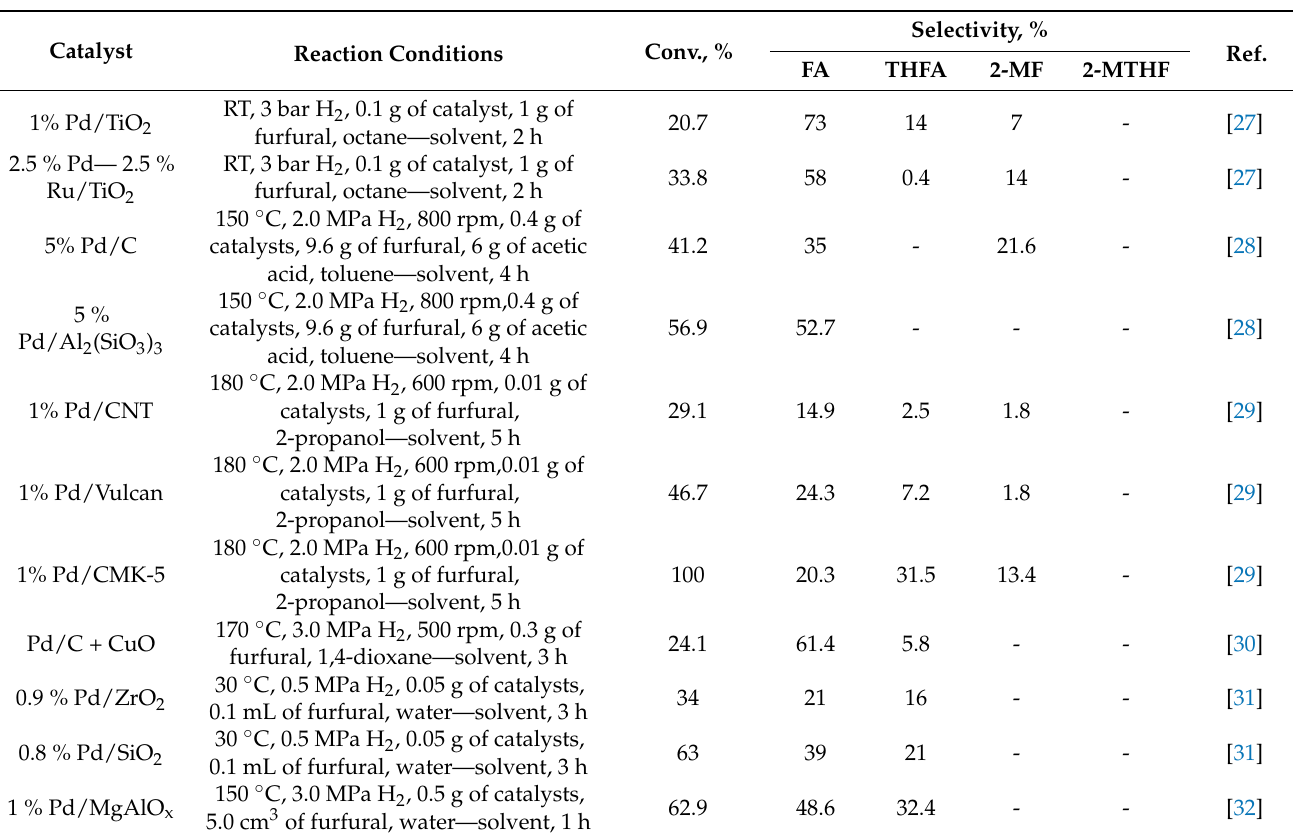
Table 1. Catalytic hydrogenation of furfural on different palladium